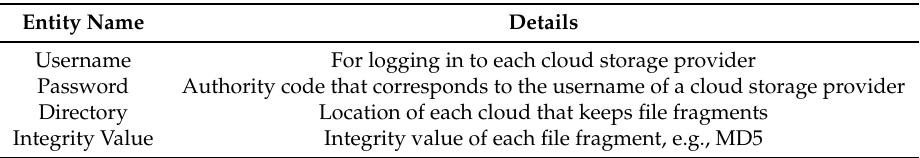
Table 2. Basic detail of the